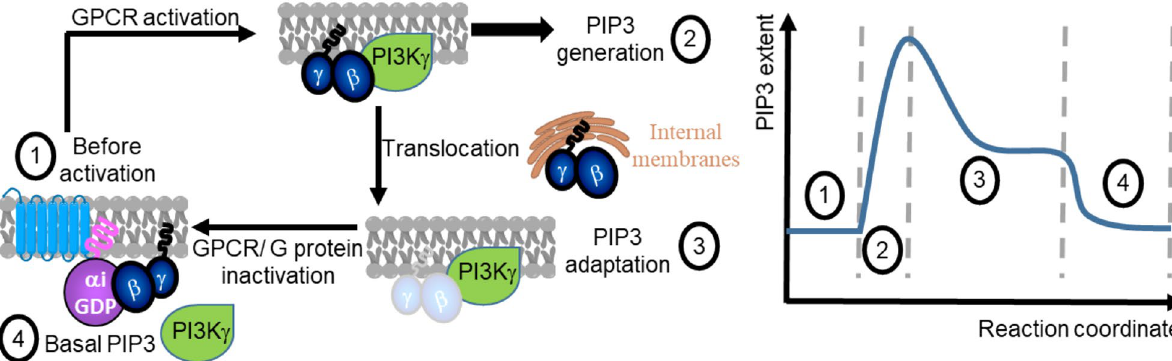
Figure 7. Proposed mechanisms for GPCR-G protein-induced PIP3 regulation. Gi/o-coupled GPCR activation induces robust free Gβγ, which stimulates PI3Kγ resulting in PIP3 generation (1). The subsequent partial PIP3 attenuation (2) is due to the translocation of Gβγ away from the plasma membrane to the internal membranes. The steady state of partial PIP3 attenuation is achieved at the equilibrium of Gβγ translocation between the plasma membrane and the internal membranes. Complete inactivation of GPCR or G proteins result in the PIP3 level returning to the basal